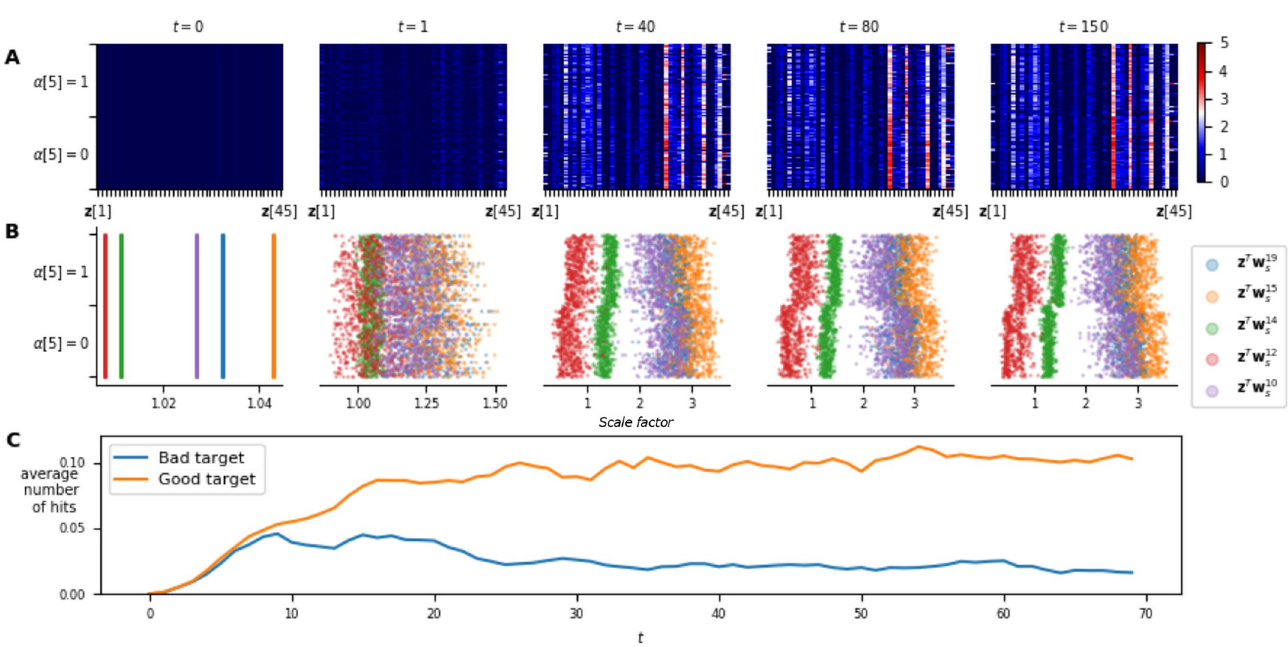
Fig 9. Adaptation capabilities of the NMN architecture on benchmark 3. A . Temporal evolution of the neuromodulatory signal z with respect to α [5], gathered on 1000 different episodes. Note that the neuromodulatory signals go from uniform distributions over all possible alpha values (i.e., the different contexts) to non- uniform and adapted (w.r.t. alpha) distributions along with an increase of the rewards. B . The value of the scale factors with respect to α [5] for the 5 neurons of a hidden layer in the main network, for which the scale factor is the most correlated to α [5]. C . Average number of good and bad target hits at each time-step during those episodes. On average, after 15 time-steps, the agent starts navigating towards the correct target while avoiding the wrong one.